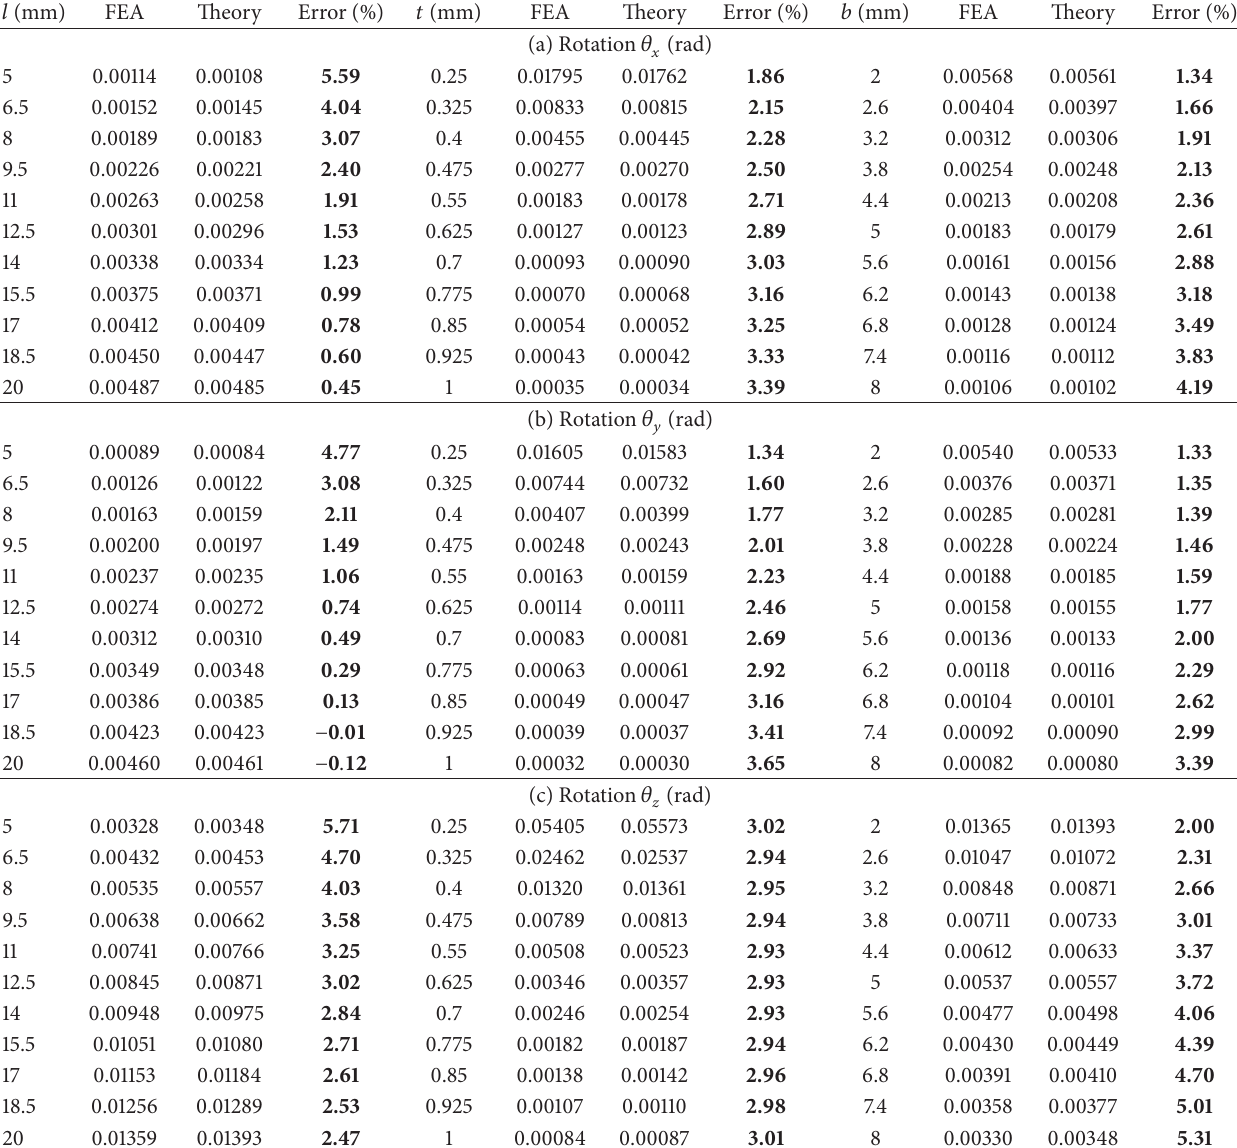
Table 3: Theoretical and FEA results with various lengths 𝑙 , thicknesses 𝑡 , and widths 𝑏 under loads 𝑇 𝑥 , 𝑀 𝑦 , and 𝑀 𝑧